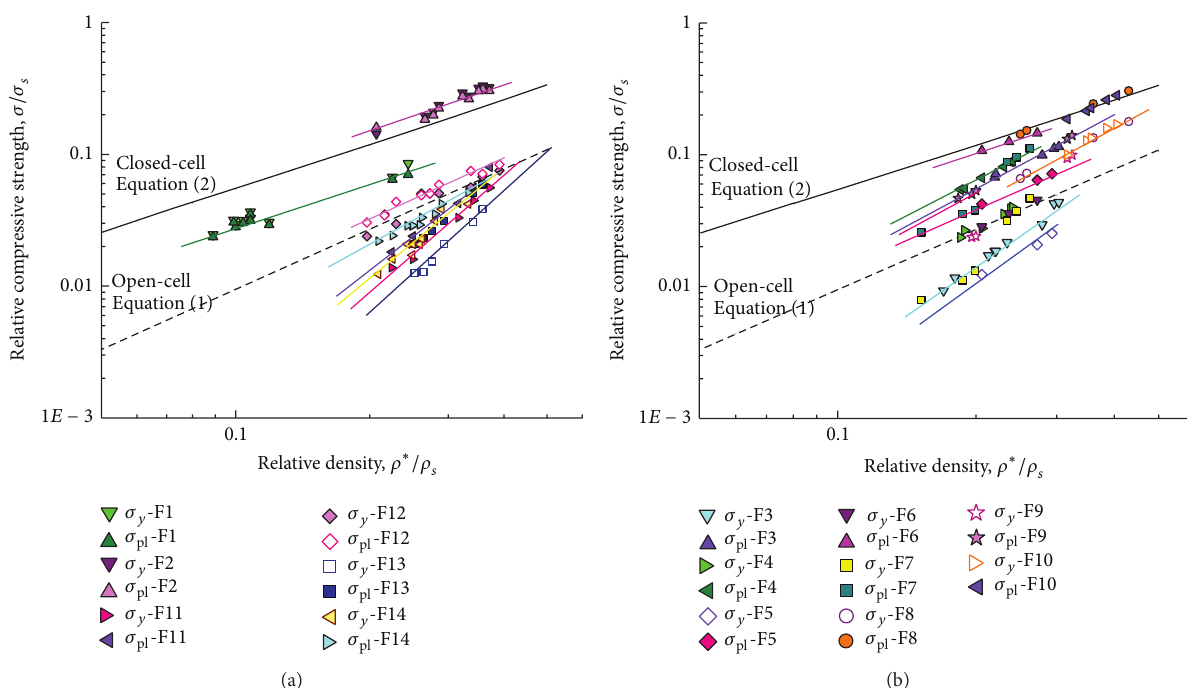
/𝜎 Figure 4: Relative compressive strength, 𝜎 𝑦 /𝜎 and 𝜎 , plotted against relative density, 𝜌/𝜌 𝑠 , for different kinds of hydride (F1, F3, F4, and ys pl ys F7–F12) and carbonate (F2, F5, F6, F13, and F14) kinds of Al/Al alloy foams performed with (F1–F3, F5, F7, F9, F11, and F13) and without (F4, F6, F8, F10, F12, and F14) Ca additive: (a) Al-foams processed with Al (F1 and F2) and Al-foams of Al-Zn-Mg alloy (F11–F14); (b)